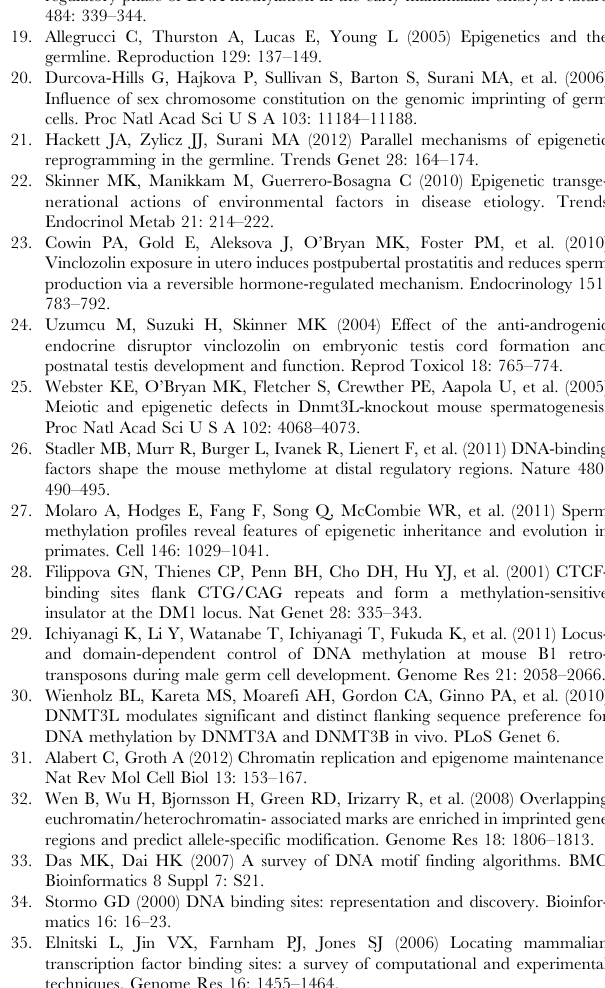
(Figure 1). The incidence of G quadruplexes and A/T strings in DMR sets were computed with R (R Development CoreTeam (2010), R: A language for statistical computing, R Foun-dation for Statistical Computing, Vienna, Austria. ISBN 3-900051-07-0, URL http://www.R-project.org). For this, matches for GGGG and WWWW motifs were interrogated, respectively. The number of matches per sequences was then obtained and the density of matches per sequence sets was calculated. Figures showing visualization of all motif incidences (GLAM2 built, GGGG and WWWW) were created using CLC Workbench (Cambridge, MA).